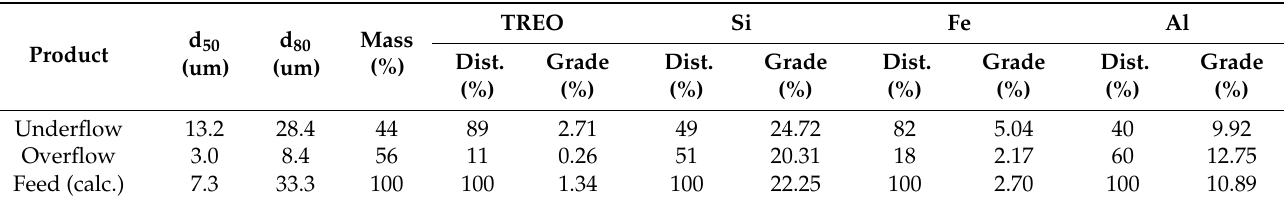
Figure 6. Particle size distribution of hydrocyclone feed and products obtained via laser diffraction method. Table 3. Results of desliming tests conducted on flotation